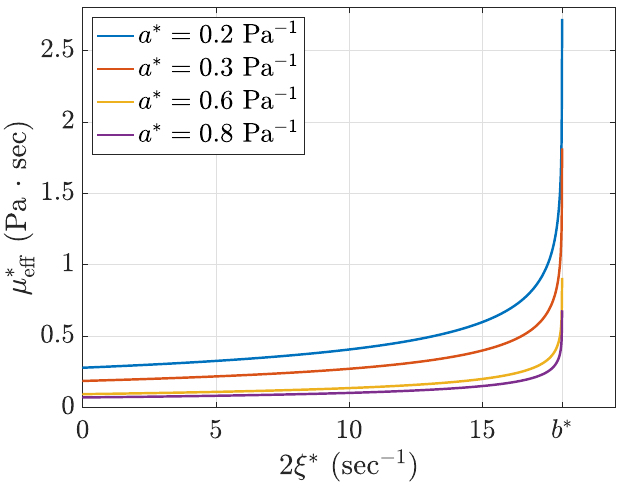
Figure 3. Plot of the effective viscosity µ ∗ given in (3) as a function of the shear rate 2 ξ ∗ for different eff values of a ∗ and b ∗ = 18 s − 1 . The values of these parameters are taken from